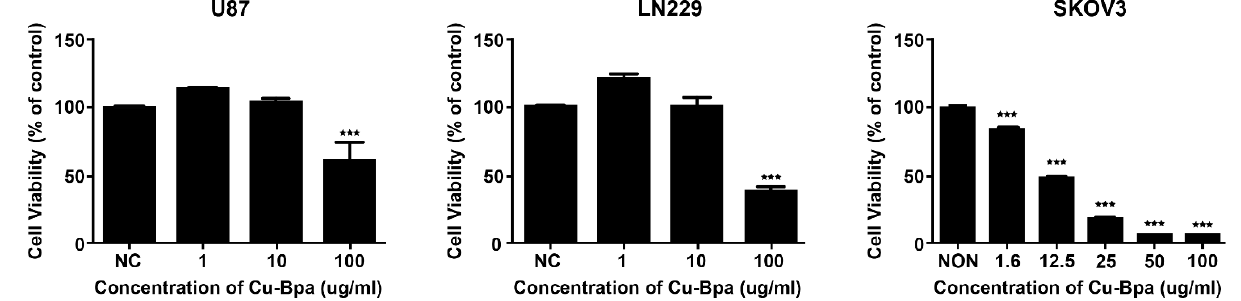
Figure 8. In vitro anticancer activity of MOFs in glioblastoma U87G and LN229 cells, and ovarian cancer SKOV3 cells. Cell viability in each sample was detected using alamar blue dye following incubation with a MOF for 24 h. All values are presented as means ± SD of three independent ex- periments. *** p < 0.001.